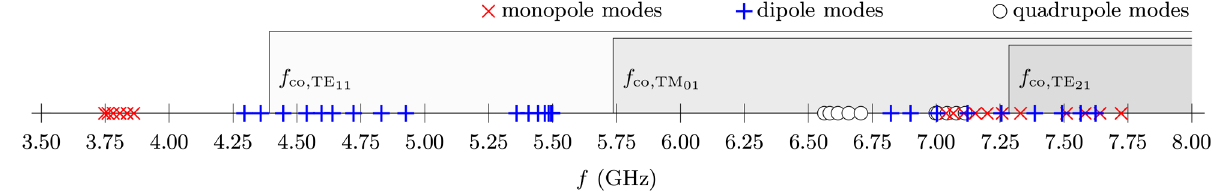
FIG. 4. Numerically computed resonant frequencies of eigenmodes of the third harmonic cavity without couplers and electric boundary conditions enforced at end of the beam pipes [11]. Monopole modes are depicted as red crosses, dipole modes as blue plusses, and quadrupole modes as black circles. The regions where the TE 11 , the TM 01 , and the TE 21 waveguide modes can propagate are depicted in terms of grey shaded rectangular frames (refer to Table IV for the cutoff frequencies). The plot shows that only the nine eigenmodes of the first monopole band and the first two eigenmodes of the first dipole band have to be confined in the individual cavities because their resonant frequencies are below the cutoff frequency of the fundamental waveguide mode of the beam pipe. The remaining eigenmodes may be distributed along the individual cavities of the chain as they can couple via the beam pipes to the adjacent